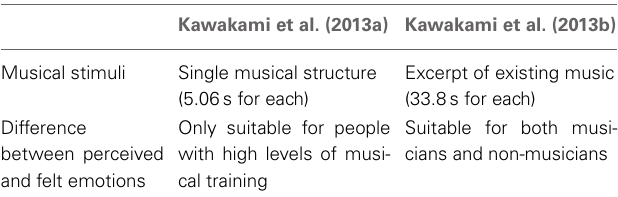
Table 2 | Effect of musical training on the difference between perceived and felt